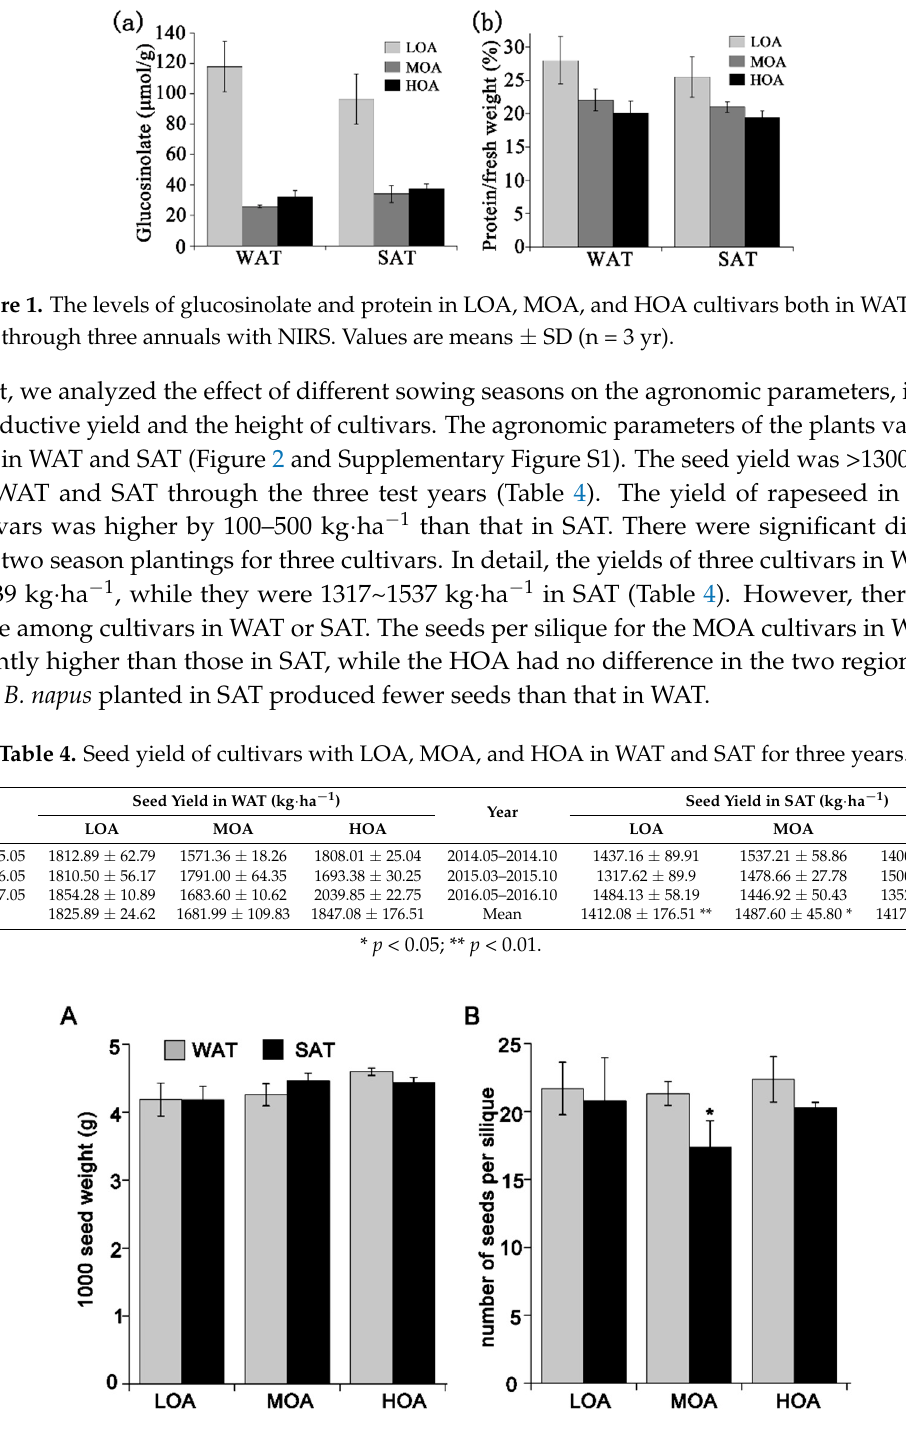
Figure 2. 1000-seed weight ( A ) and number of seeds per silique ( B ) for all cultivars in WAT and SAT in Figure 2. 1000 ‐ seed weight (A) and number of seeds per silique (B) for all cultivars in WAT and SAT the third annual. Values are means ± SD (n = 3 plots). * p < in the third annual. Values are means ± SD (n = 3 plots). * P < 0.05.